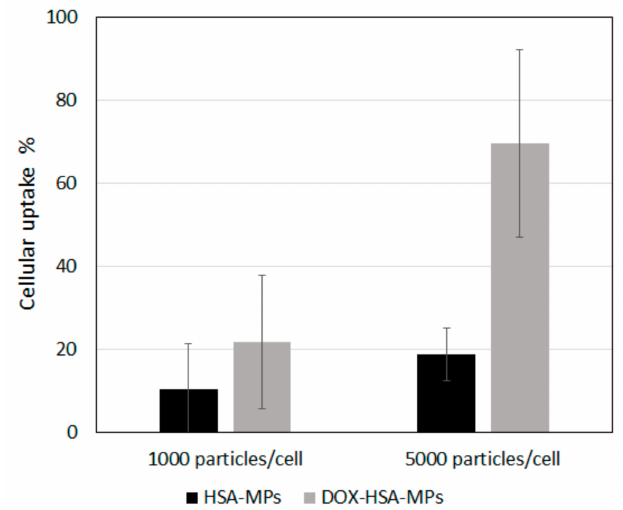
Figure 7. Cellular uptake of HSA-MPs and DOX-HSA-MPs (1000 and 5000 particles / cell) by A549 cells after culturing for 24 h.